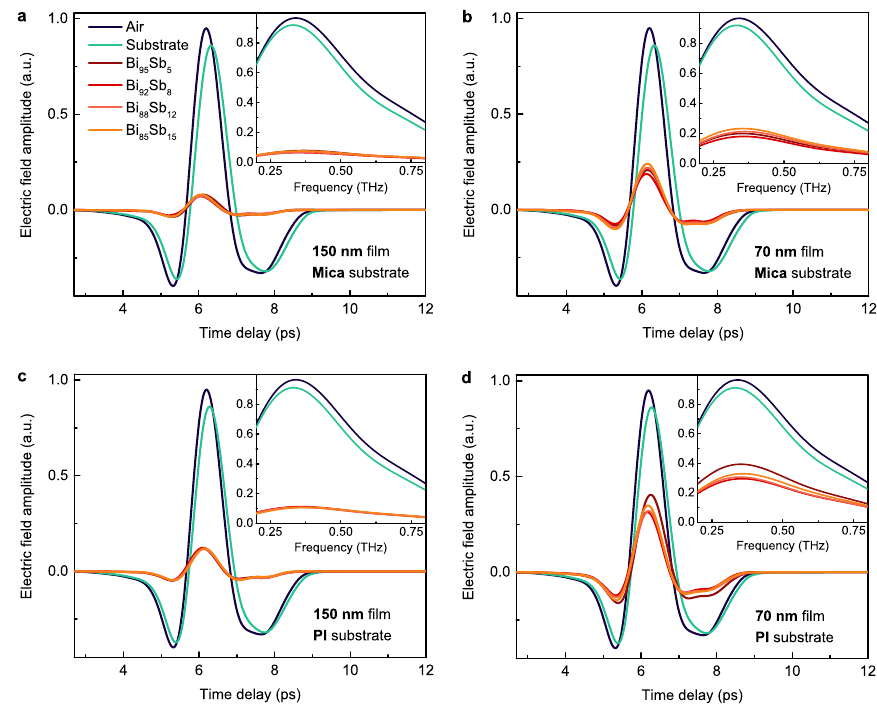
Figure 3. The temporary dependencies of a relative electric field amplitude of THz wave (THz waveforms) transmitted through the air, mica ( a , b ) and PI ( c , d ) substrates and full substrate/film structures for film thicknesses of 150 nm ( a , c ) and 70 nm ( b , d ) and in cases of various Sb concentrations. The corresponding amplitude spectra are shown in the insets for 0.2–0.8 THz frequency range.